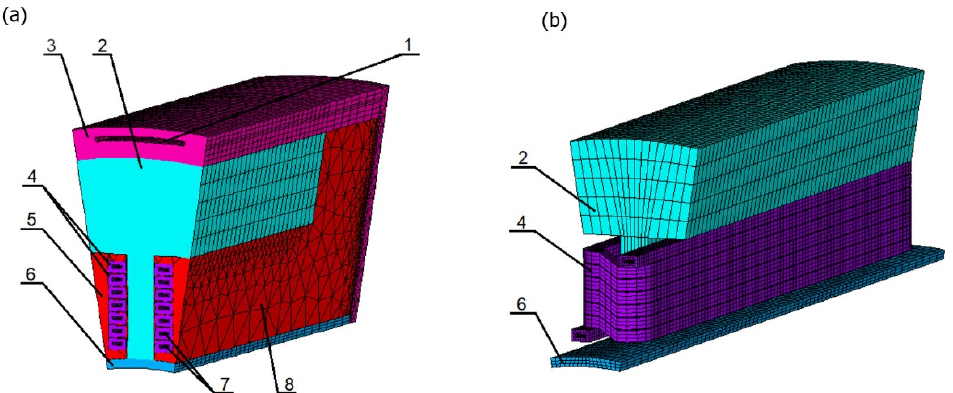
Figure 3. Finite elemental models 1/6 EMM: ( a ) half-section of the model; ( b ) the core of the inductor along with the coil and a fragment of the wall of the working chamber; 1: channels in the frame; 2: inductor; 3: frame; 4: coil; 5: compound; 6: the wall of the working chamber; 7: channels in the coil; and 8: adiabatic wall.